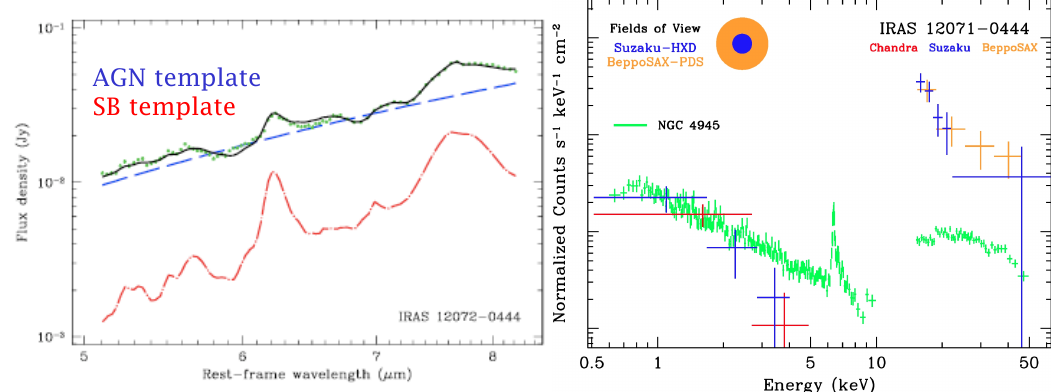
Figure 3: IRAS12071-0444 data. Left: the Spitzer/IRS ∼ 5 − 8 µ m spectrum (green dots) is reproduced (black line) by means of an AGN (blue dashed line) and SB (red dot-dashed line) templates. Right: Suzaku data (blue) well agrees with the Chandra/ACIS spectrum (red) in the 0.5-5 keV range, and beyond 15 keV with the BeppoSAX/PDS points (orange). The shaded blue and orange areas in the upper left corner allow to compare Suzaku and BeppoSAX/PDS fields of view respectively. I also compare IRAS 12071-0444 with the NGC 4945 X-ray spectrum observed by XMM-Newton (green). The NGC 4945 data are scaled to match IRAS 12071-0444 at 0.5–10